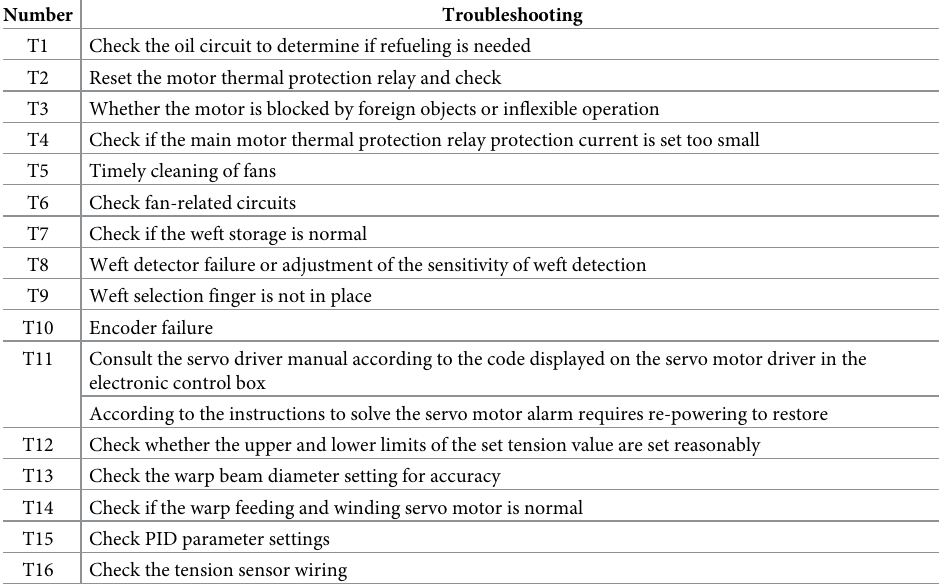
Table 2. Common repair